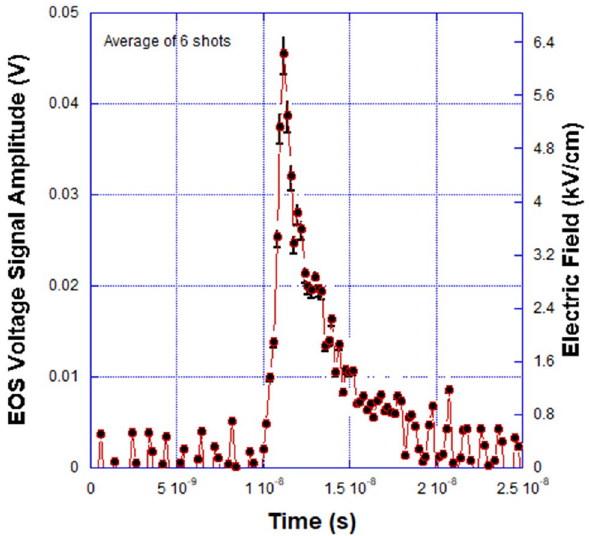
Figure 2. Benchtop laboratory EOS signal amplitude versus time for a series of six shots. The average peak pulse amplitude and electric field were 45.46 mV and 6.26 kV/cm compared to the expected values of 46.21 mV and 6.32 kV/cm from the calculation. The average pulse width for the EOS signals was 2.11